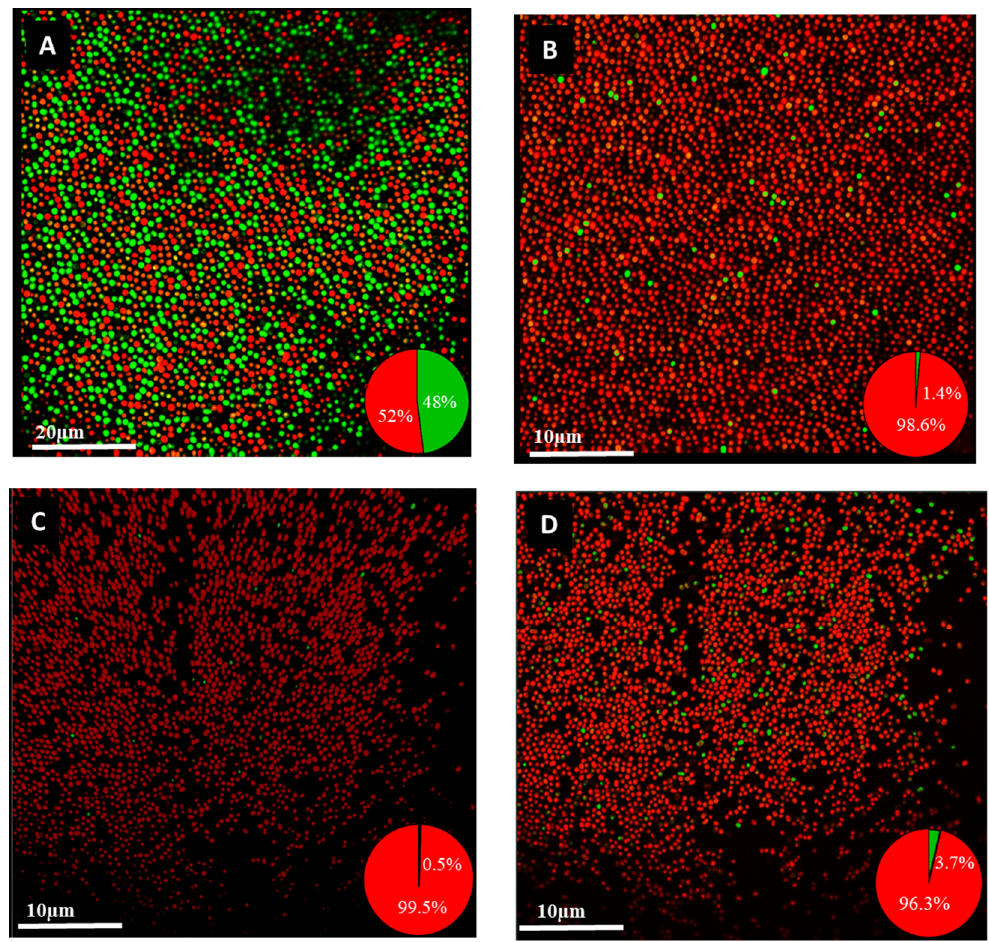
Figure 1. CLSM images of A. baumannii ST1894 biofilm treated with bactericidal antibiotics. ( A ) Untreated biofilm cells, ( B ) biofilm treated with 512 μ g/mL imipenem, ( C ) biofilm treated with 128 μ g/mL colistin, ( D ) biofilm treated with 512 μ g/mL ciprofloxacin. Biofilm was incubated